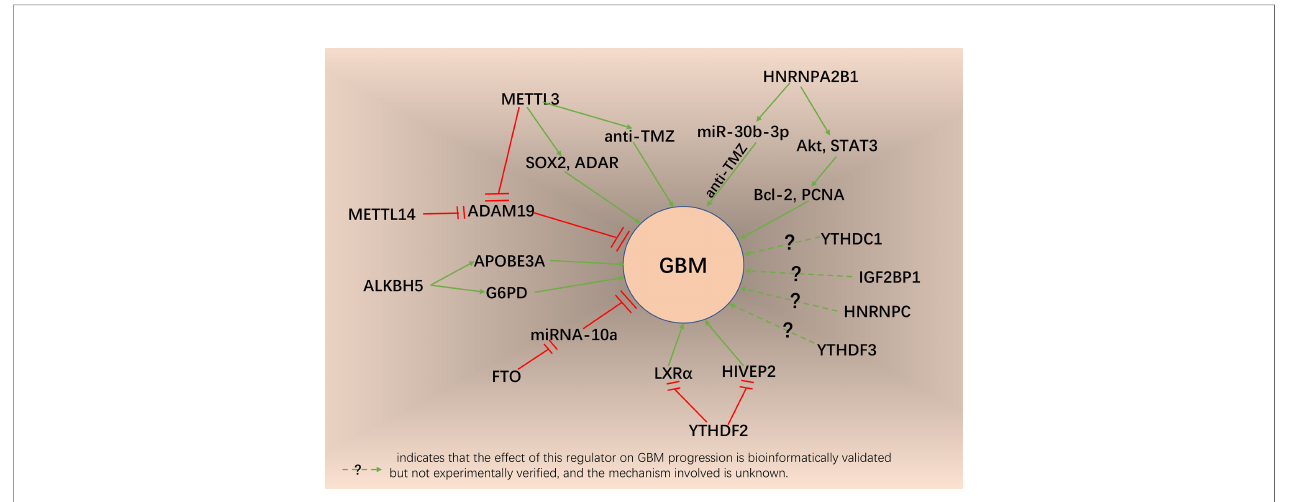
FIGURE 4 | The potential role of m6A regulators in GBM progression and related